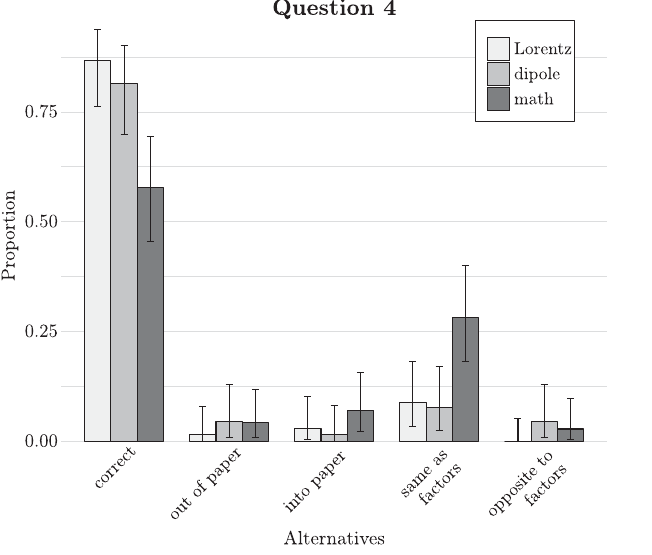
FIG. 5. Students ’ answers on the question 4 about the cross product of two parallel vectors. Error bars indicate the 95% con- fidence intervals based on the Clopper-Pearson method.